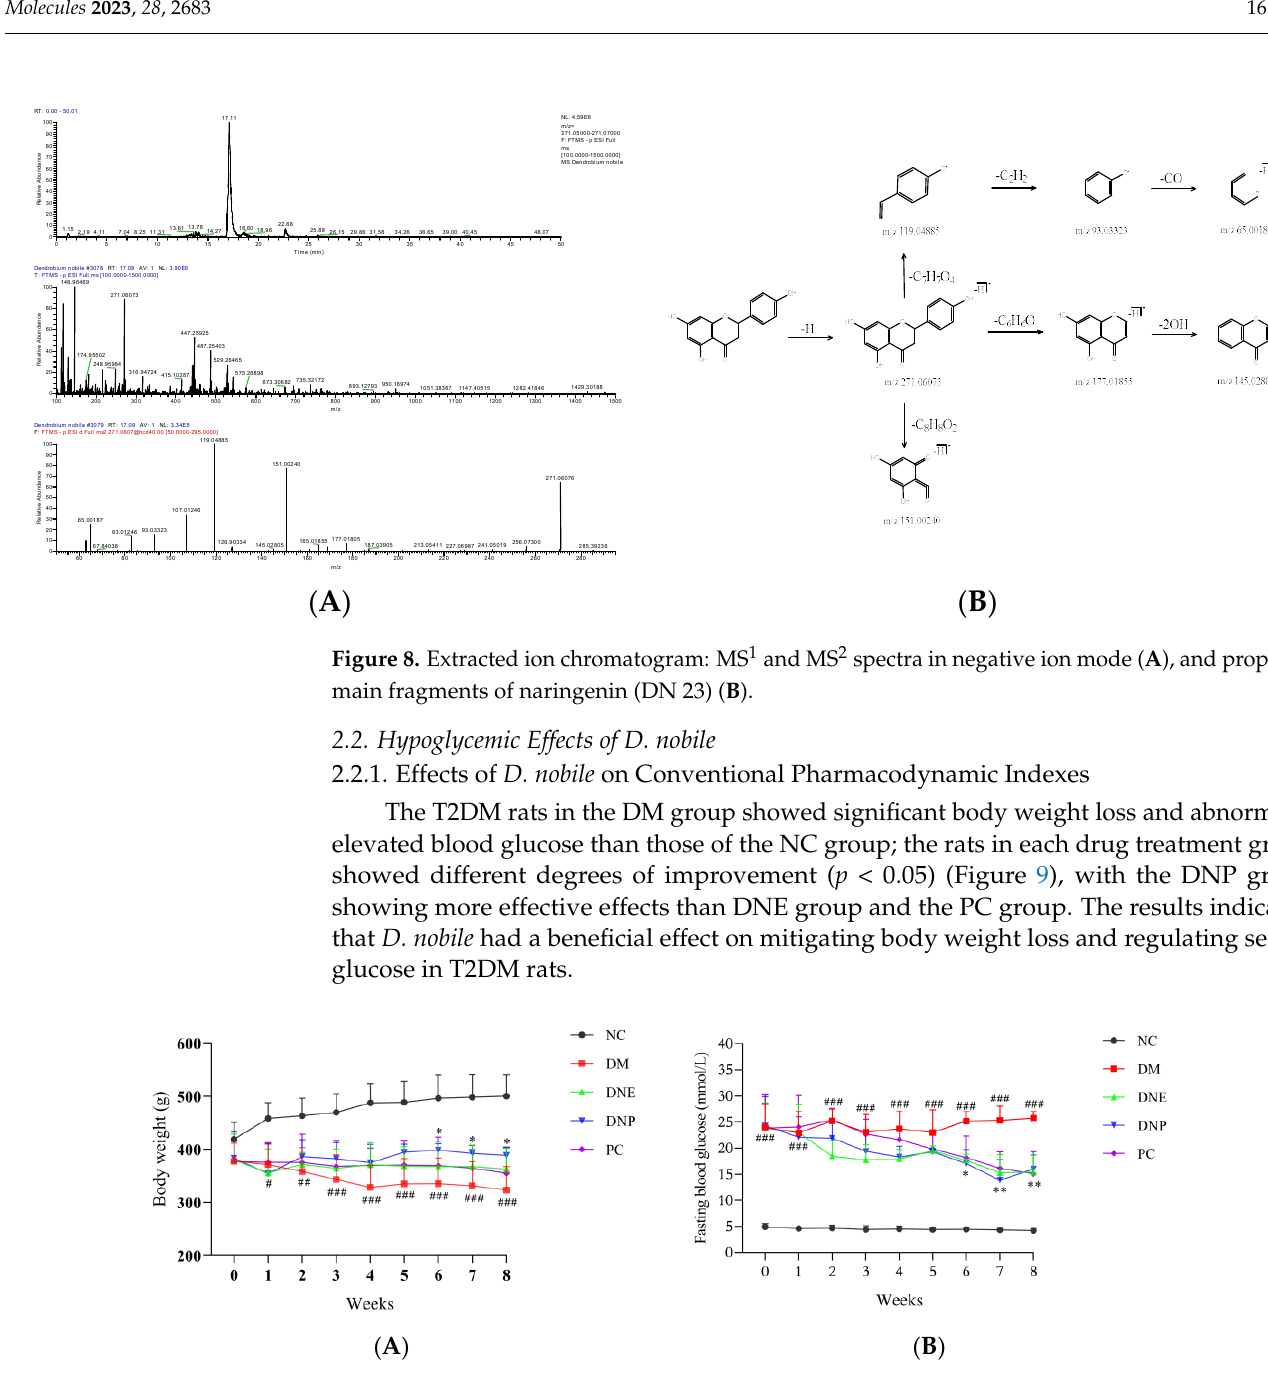
( B ) Figure 7. Extracted ion chromatogram: MS 1 and MS 2 spectra in negative ion mode ( A ), and proposed main fragments of 2-methoxy-9,10-dihydrophenanthrene-4,5-diol (DN 32) ( B ). 2.1.4. Other Other compounds included flavonoids, glycosides and so on. The molecular formula of DN 23 was C 15 H 12 O 5 , and its negative quasi-molecular ion m / z 271.06073 (ppm 2.324) [M-H] − was fragmented into fragment ions m / z 119.04885 [M-H-C 7 H 7 O 4 ] − , m / z 177.01855